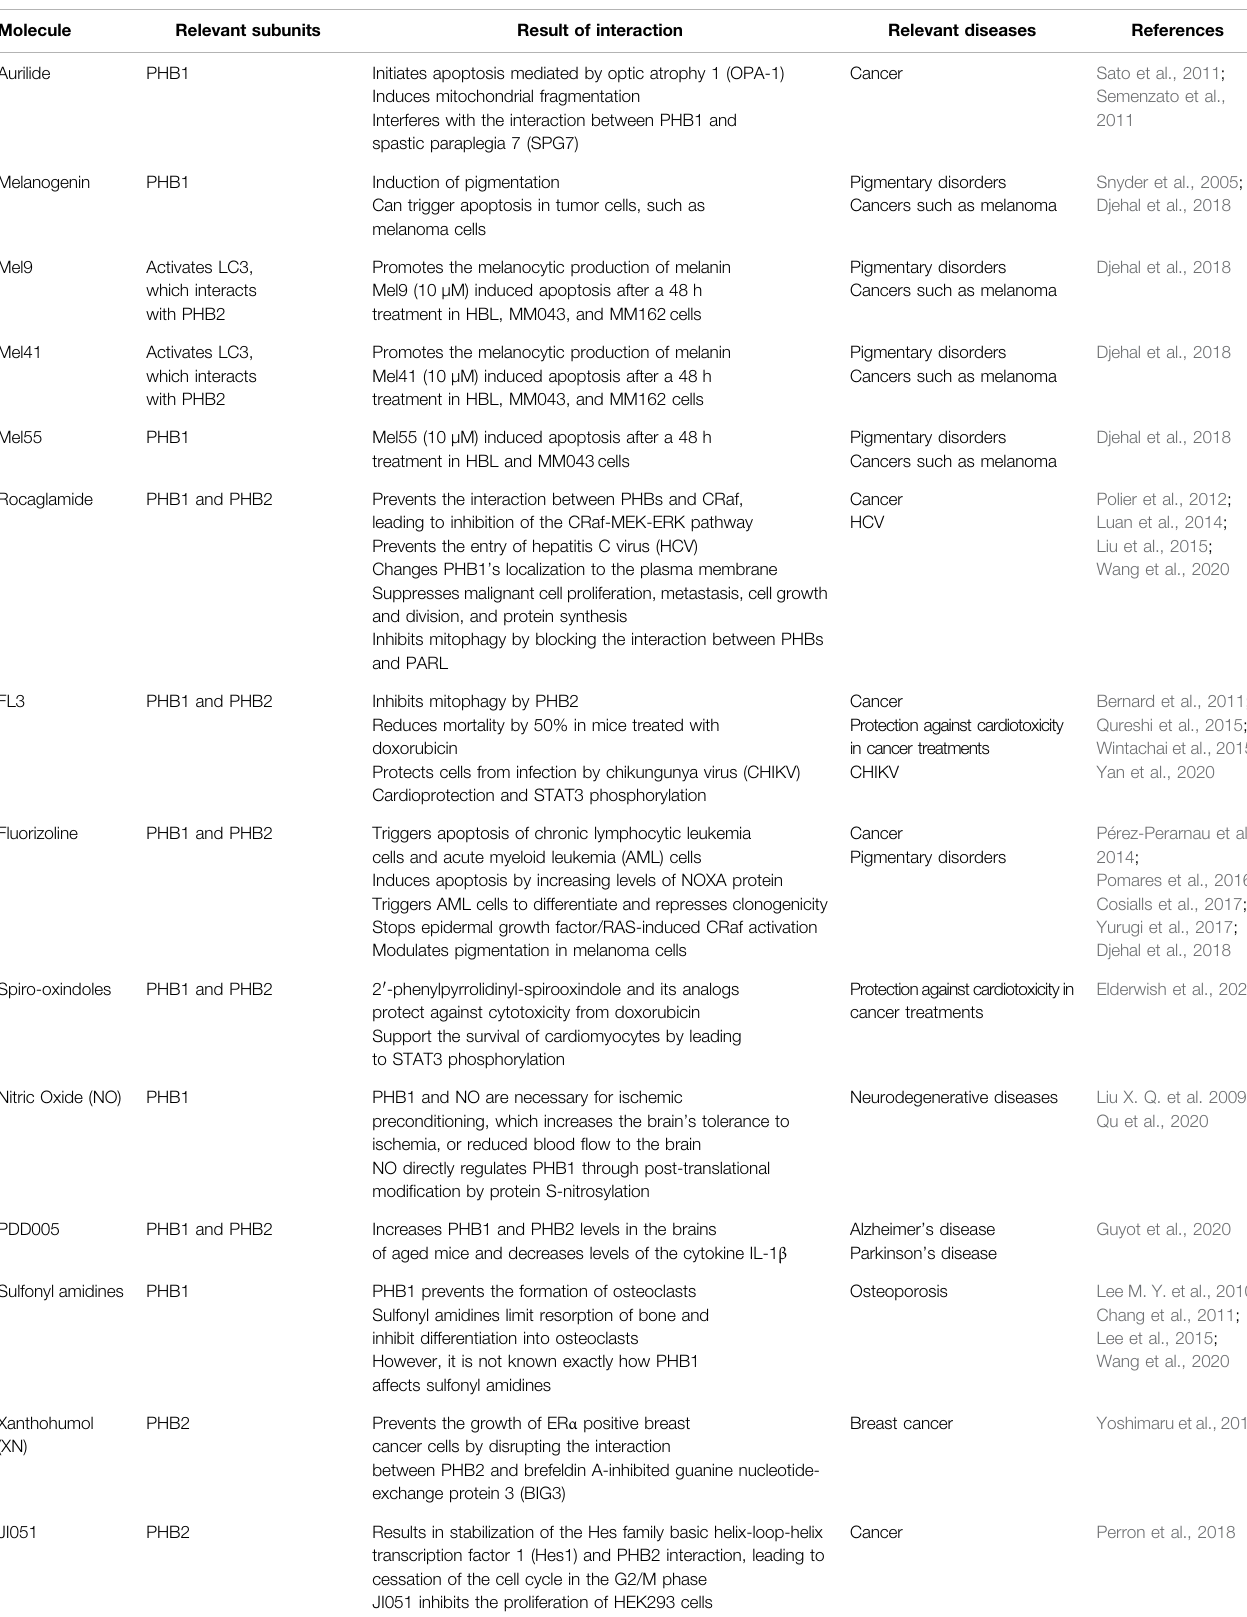
TABLE 1 | Small molecules that interact with PHBs and their relevance to age-related